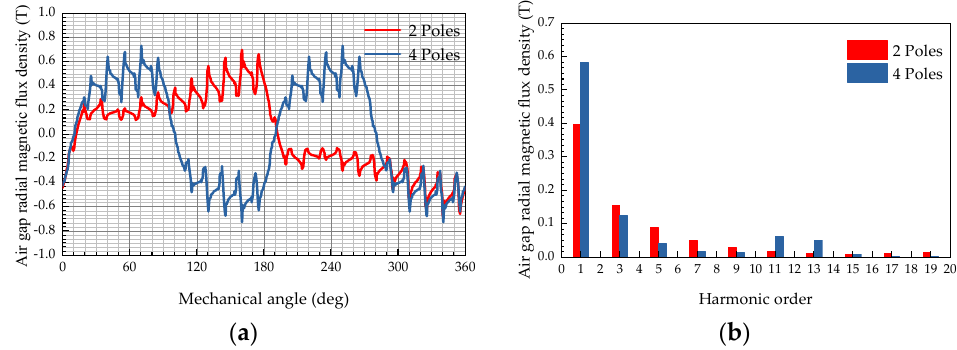
Figure 9. Radial air ‐ gap flux density of two ‐ pole and four ‐ pole motor under rated load: ( a ) radial air ‐ gap flux density with mechanical angle; ( b ) Fourier transforms.